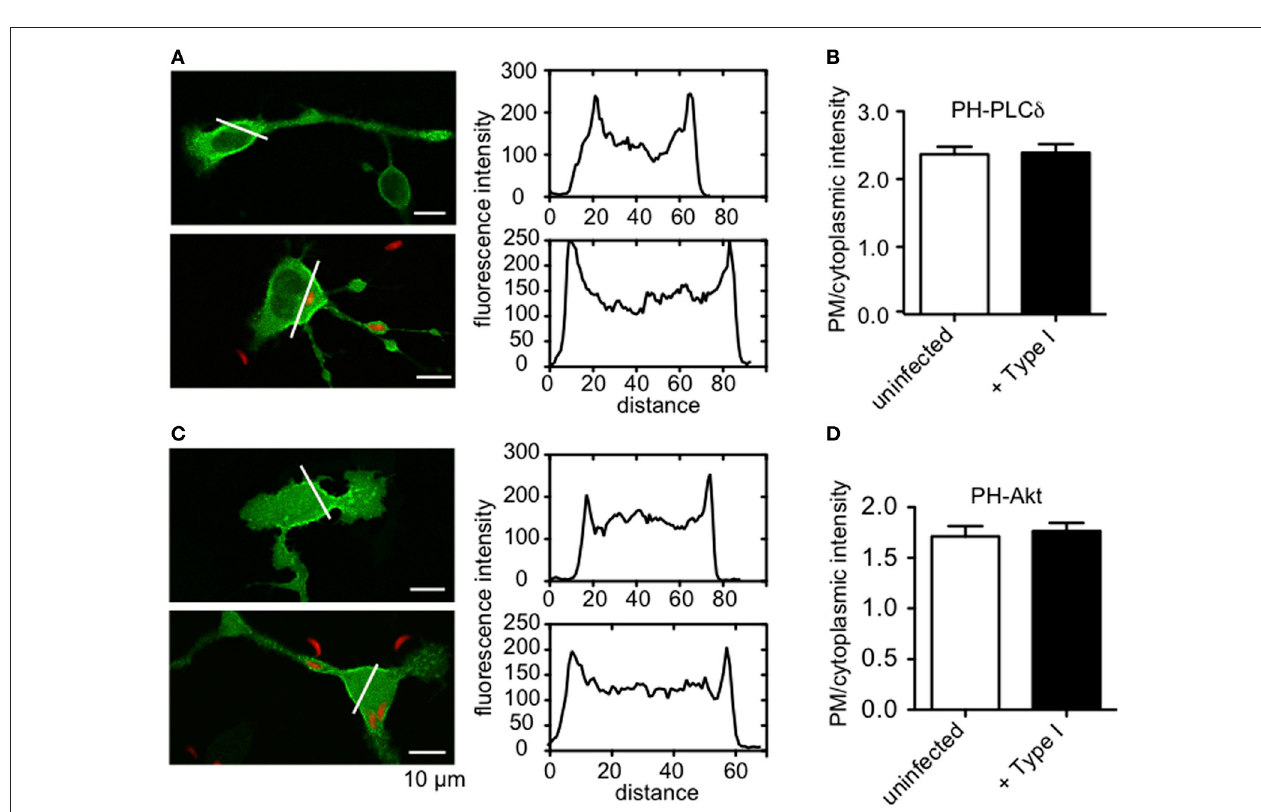
FIGURE A1 | PIP 2 and PIP 3 levels at the plasma membrane are not altered by T. gondii infection. (A) Representative images showing uninfected (top) or RH-tomato infected (bottom) RBL cells transiently transfected with PH-PLC δ -EGFP. Accompanying fluorescence intensity profiles are taken along the white lines indicated in each image. (B) Ratio of plasma membrane to cytoplasmic PH-PLC δ -EGFP fluorescence [given by intensity profiles as shown in (A) ] as a relative measure of PIP 2 at the plasma